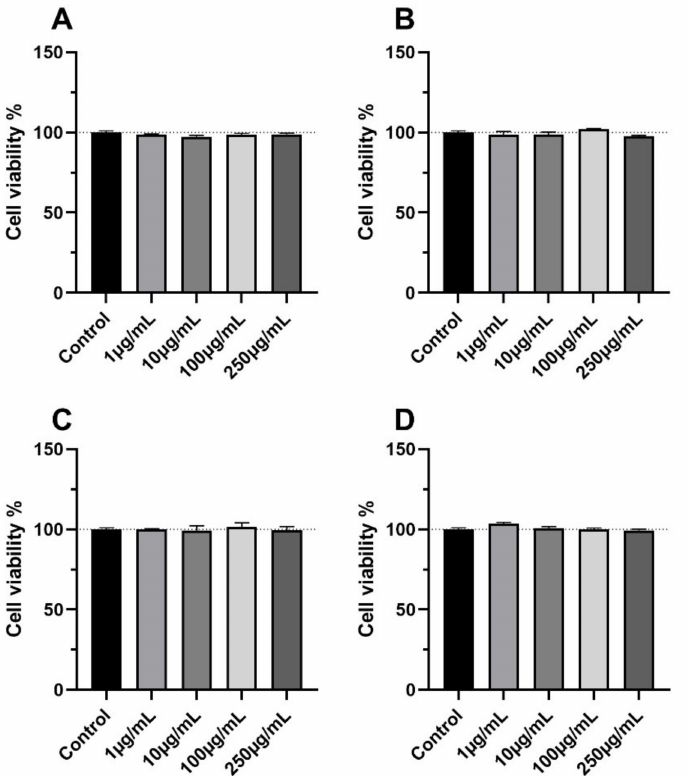
Figure 6. Viability of R3/1 cells incubated with the four extracts in a 1 to 250 µ g/mL concentration range: ( A ) EtOH-H 2 O 70:30 (% v / v ); extract A; ( B ) water at 100 ◦ C, extract B; ( C ) water at 70 ◦ C extract C; ( D ) water at room temperature, extract D. Cell viability was measured by the MTT assay. All the extracts were found not to significantly change the cell viability at all the tested concentrations. Statistical significance was calculated by ANOVA analysis followed by Dunnett’s multiple comparisons. A p > 0.05 was found for all the